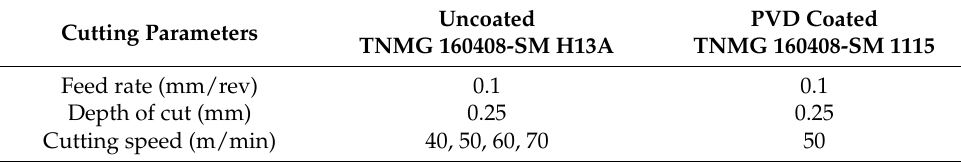
Table 3. Cutting parameters for the experimental tests. Cutting